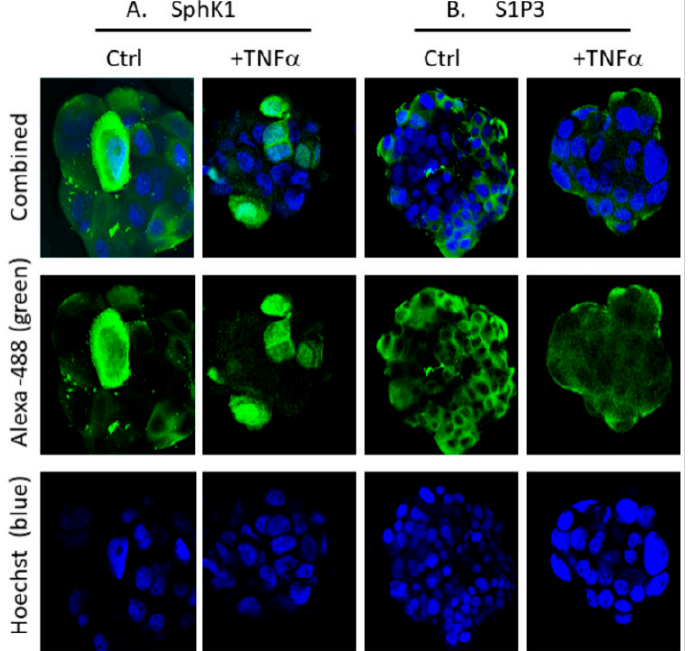
Figure 6. Localization of SphK1 ( A ) and S1P3 ( B ) was visualized in BCSC-enriched mammospheres using confocal microscopy ( × 400). ( A ). Heterogeneous SphK1 expression and localization (in cyto- plasm) was observed in vehicle-treated mammosphere cells (Ctrl). Nuclear SphK1 localization was observed in TNF α -treated cells, although the response was heterogenous. ( B ). No nuclear localization of S1P3 was observed in TNF α -treated cells. TNF α reduced S1P3 membrane localization and overall fluorescence compared to Ctrl. Images are representative of at least 3 independent